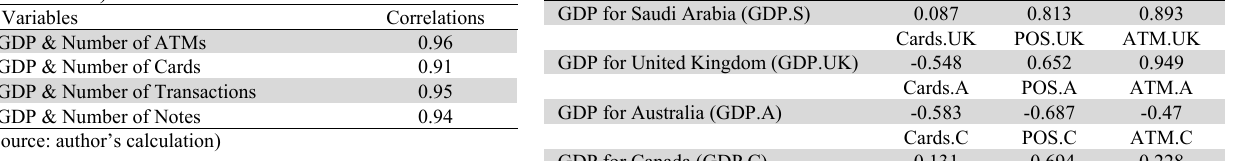
Correlations amongst key variables for Saudi Arabia Correlations (growth rate) of key parameters (2014-2018)